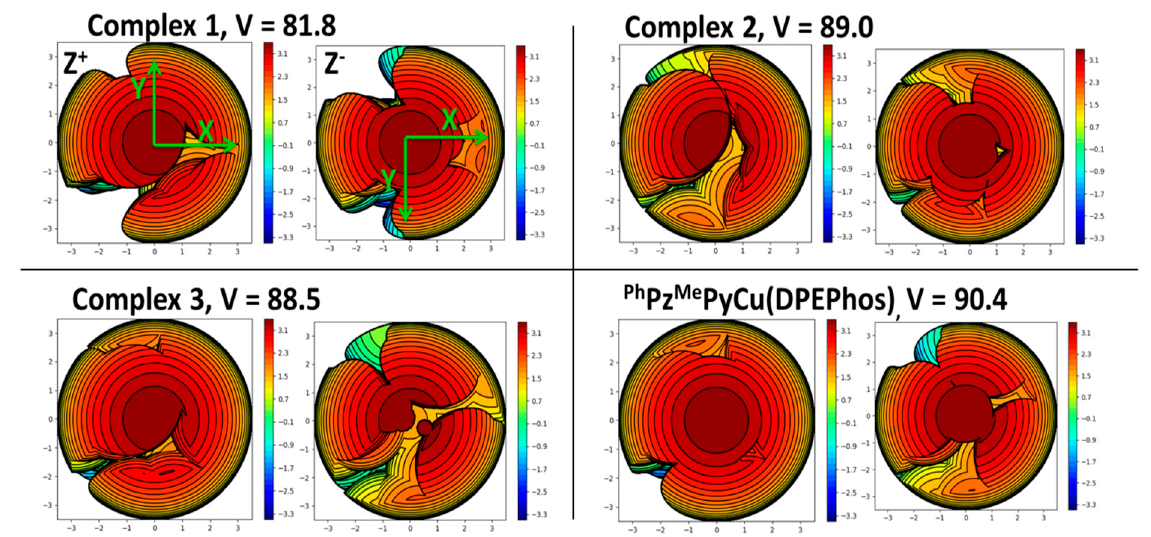
Figure 4. The buried volume representation for complexes 1 – 3 and published Ph Pz Me PyCu(DPEPhos) [40], from the top (positive Z − axis, pyridine side, left portion) and from the bottom (negative Z − axis, pyrazole NH ··· BF 4 side, right portion).